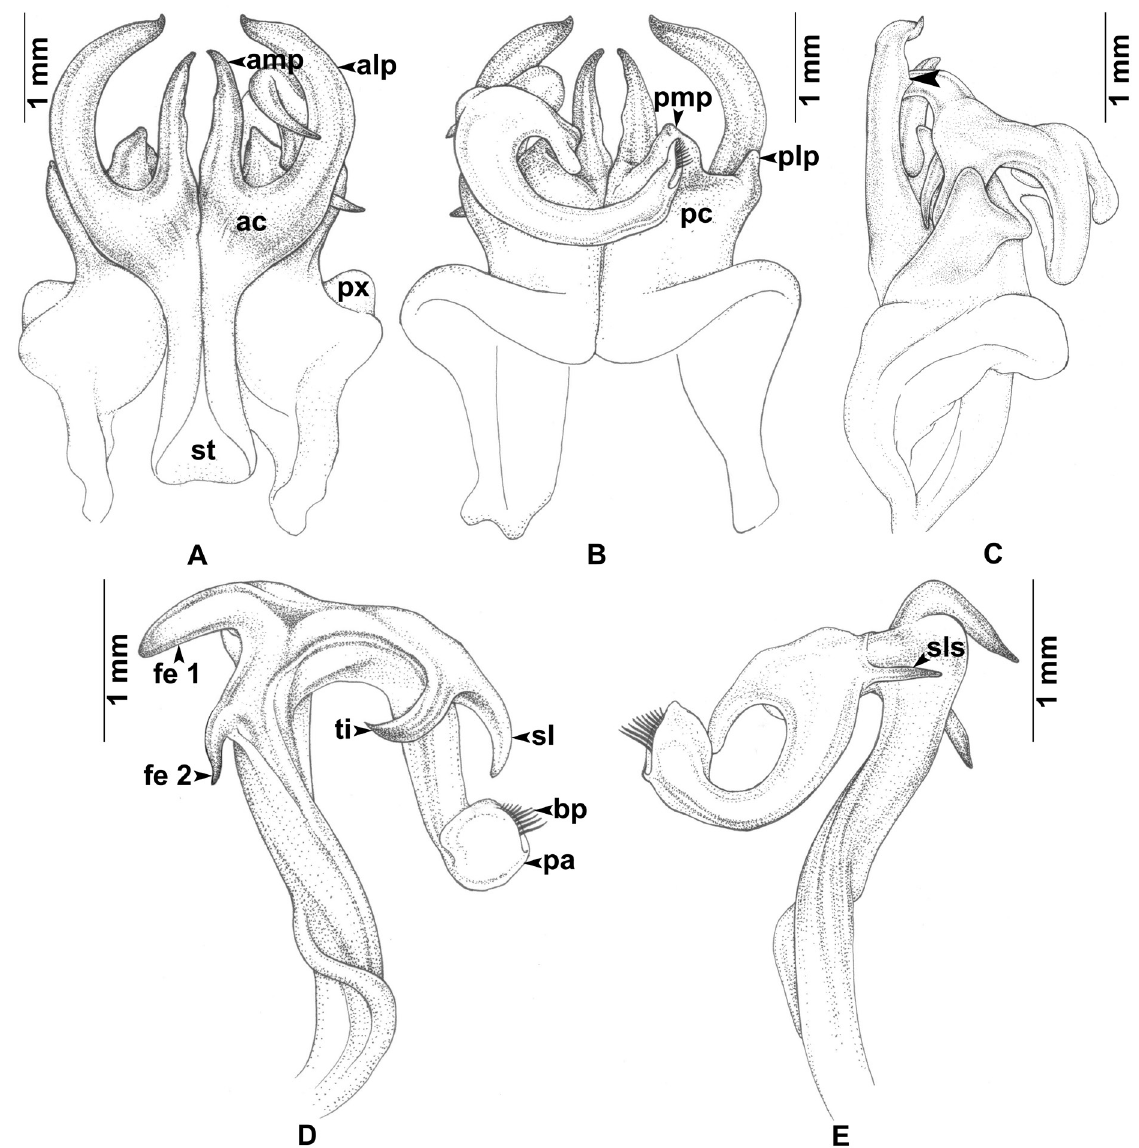
Fig. 7. Thyropygus planispina sp. nov., from Tham Sua temple, holotype (CUMZ-D00088), ♂, gonopods. A . Anterior view, left telopodite removed. B . Posterior view, left telopodite removed. C . Lateral view. D . Left telopodite, posterior-mesal view. E . Left telopodite, anterior-lateral